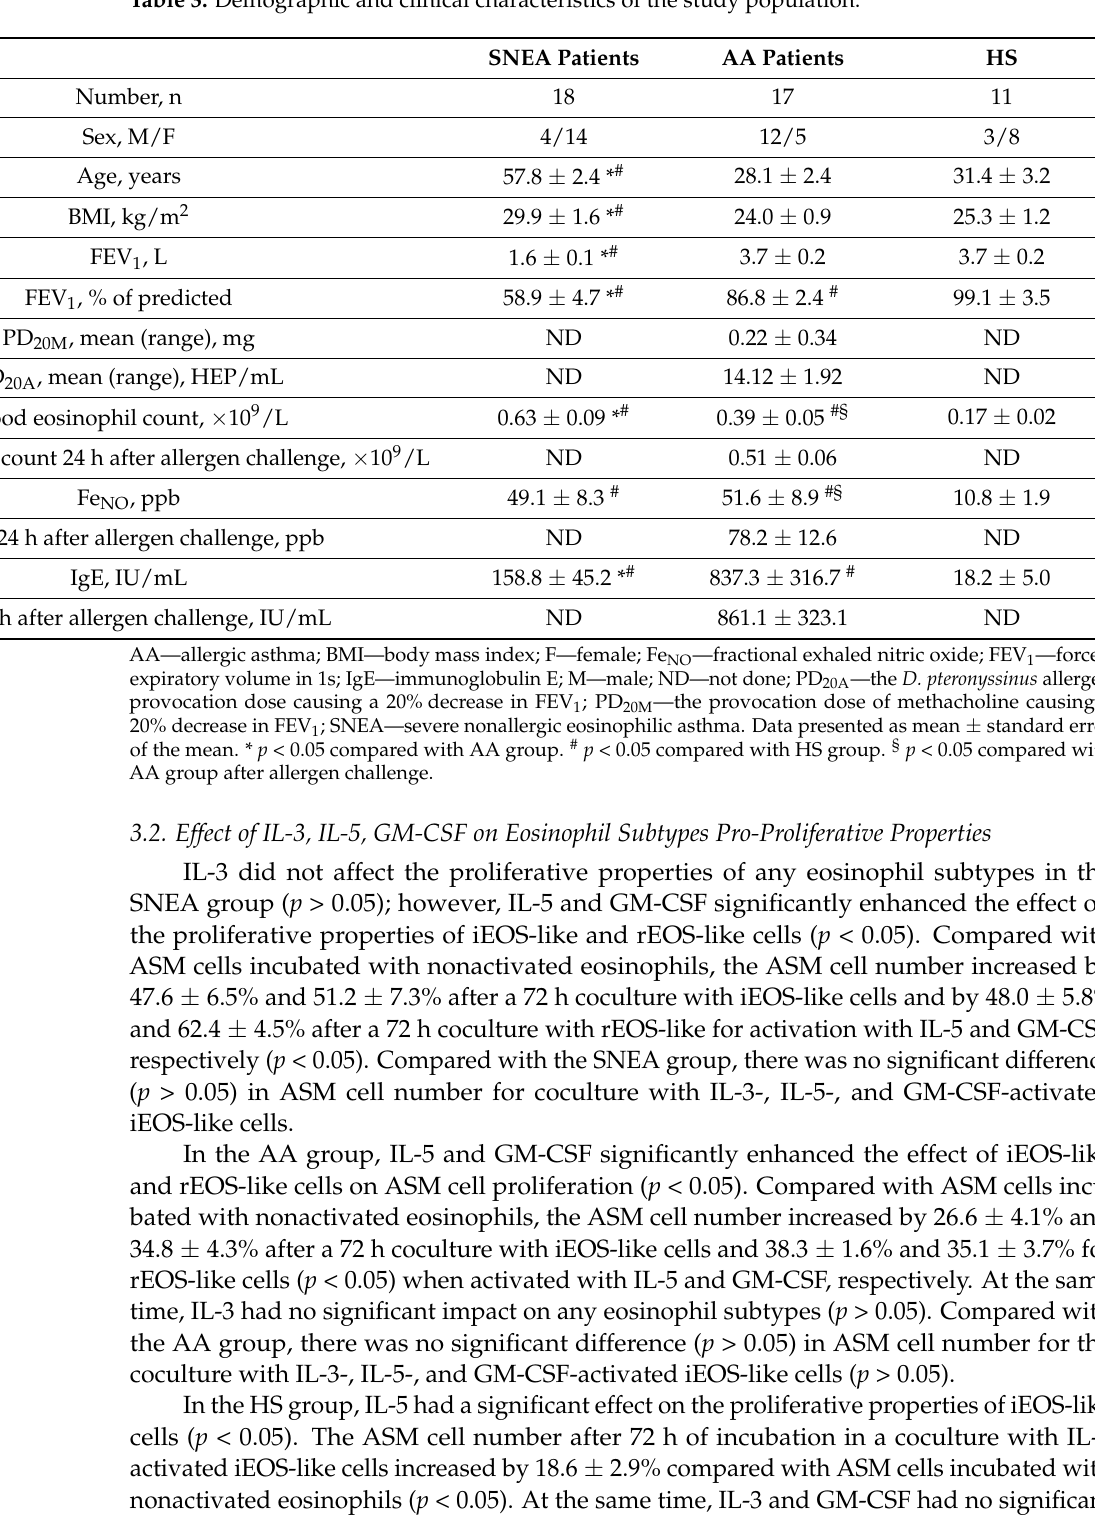
Table 3. Demographic and clinical characteristics of the study